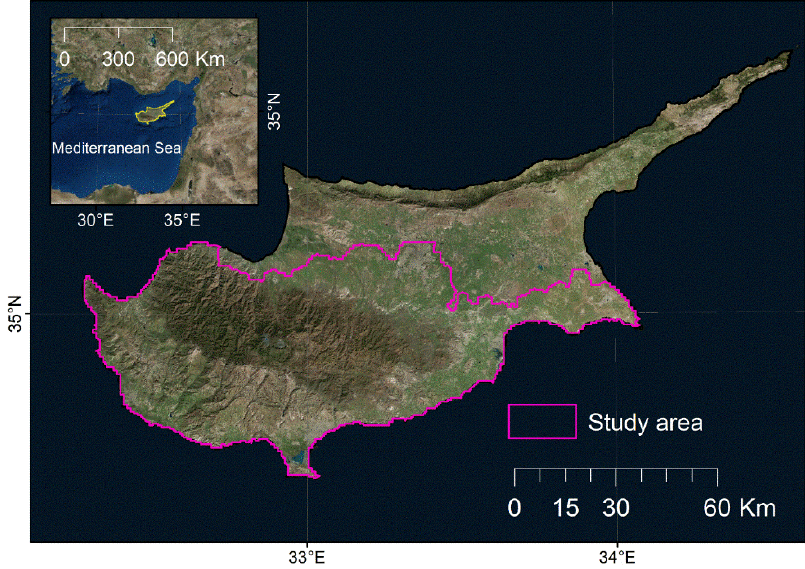
Figure 2. Cyprus Island is located in the Eastern Mediterranean Basin (see inset); the study area was addressed in the southern part of the island (basemap from